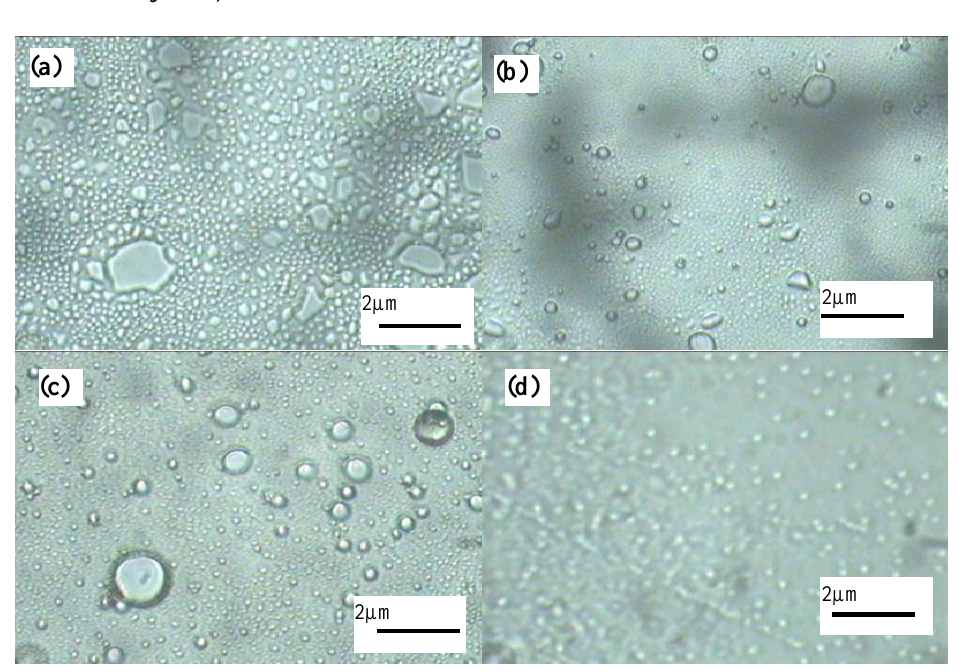
Figure 1. Photographic of ELM droplets formed under different stirring times. (Membrane phase: 6% v / v LIX 7950, 2% v / v 1-dodecanol, 5% v / v Span 80, 1% v / v paraffin,